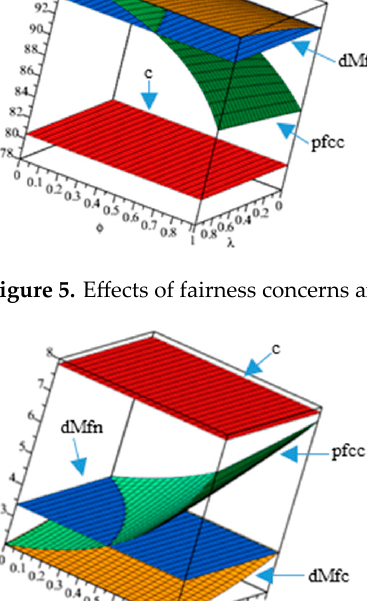
Figure 8. Effects of M’s fairness concerns on M’s profits. Figure 9. Effects of M’s fairness concerns on R’s profit degree. Figure 10. Effects of M’s fairness concerns on system profit.